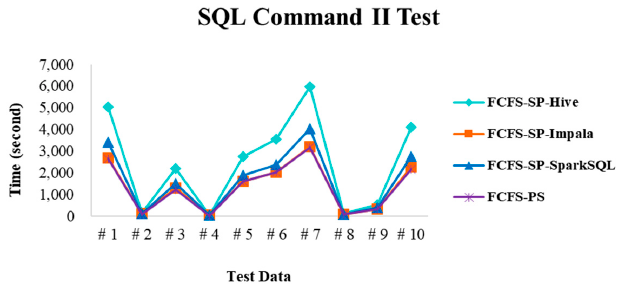
Figure 21. Execution time of SQL command II in test environment II.